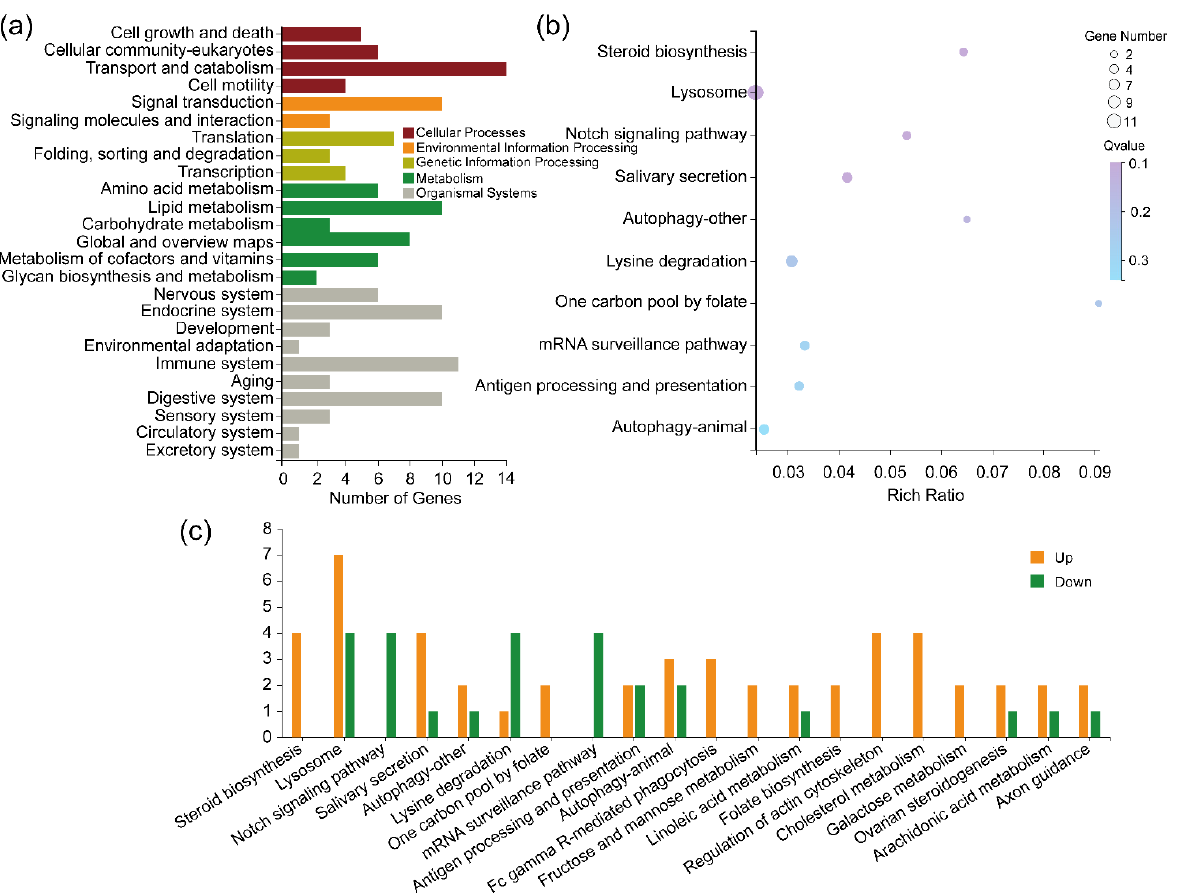
Figure 7. Kyoto Encyclopedia of Genes and Genomes (KEGG) analysis of differentially expressed genes from the cyflumetofen ‐ resistant (R_cfm) strain of T. urticae . ( a ) Classified KEGG pathways; ( b ) enriched KEGG pathways; ( c ) the number of differently expressed genes in the most enriched pathways.